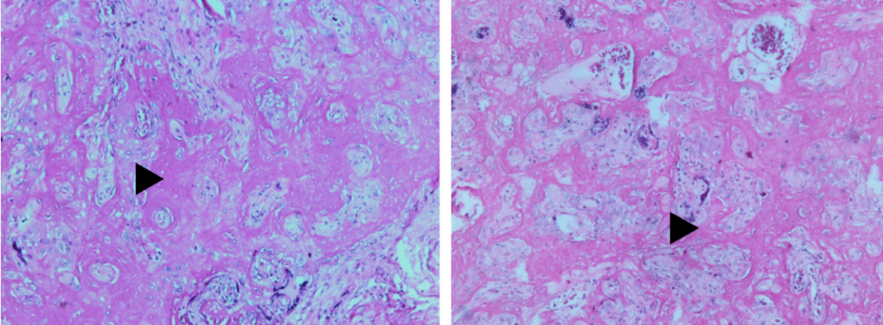
Figure 5. Presence of placental fibrinoid. The hematoxylin and eosin-stained photomicrograph of the placenta shows the chorionic villi encased by massive perivillous fibrin deposition (arrowheads). Original magnification ×